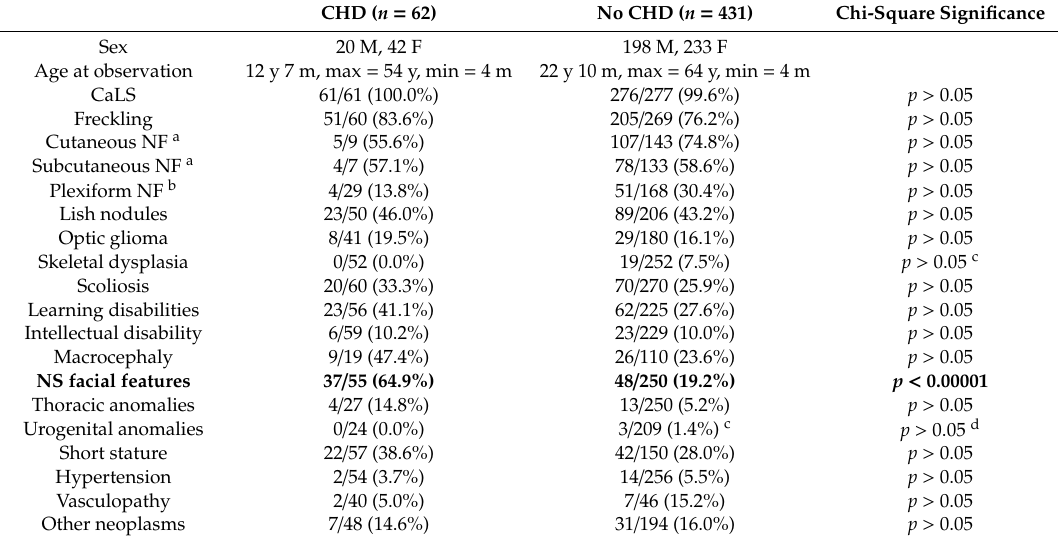
Table 2. Prevalence of non-cardiac phenotypic characteristics in neurofibromatosis type 1 (NF1) patients of present series, with and without CHD.